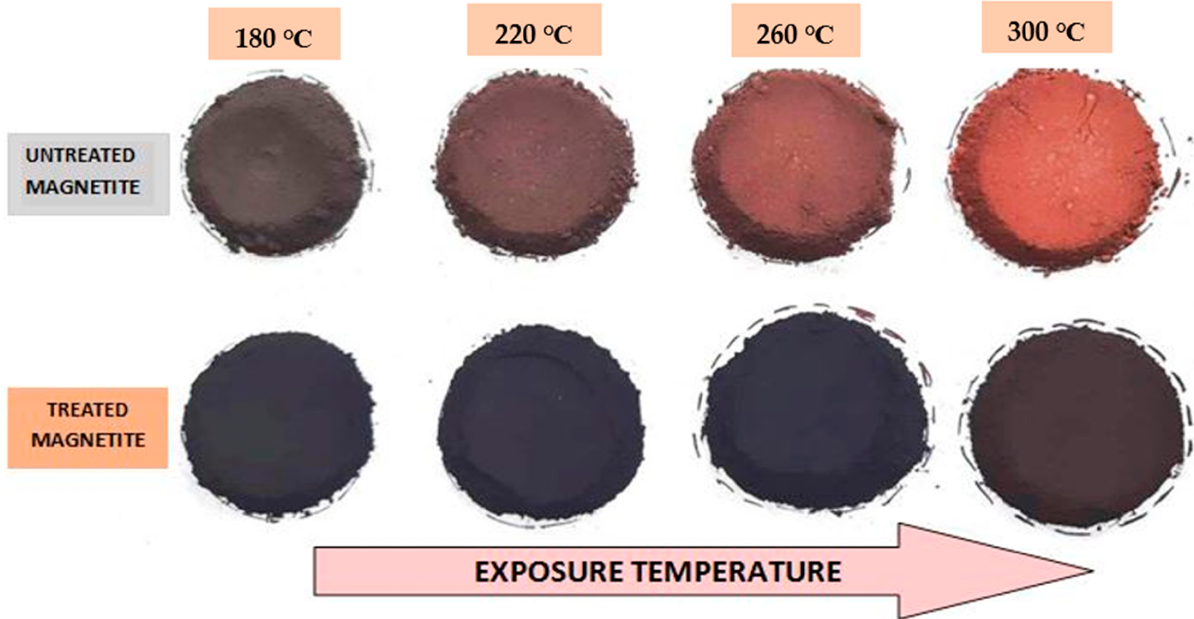
Figure 2. Photograph of untreated and SHMP-treated Fe 3 O 4 powders at different temperatures for 30 min of in situ heat exposure, exhibiting visual color changes.